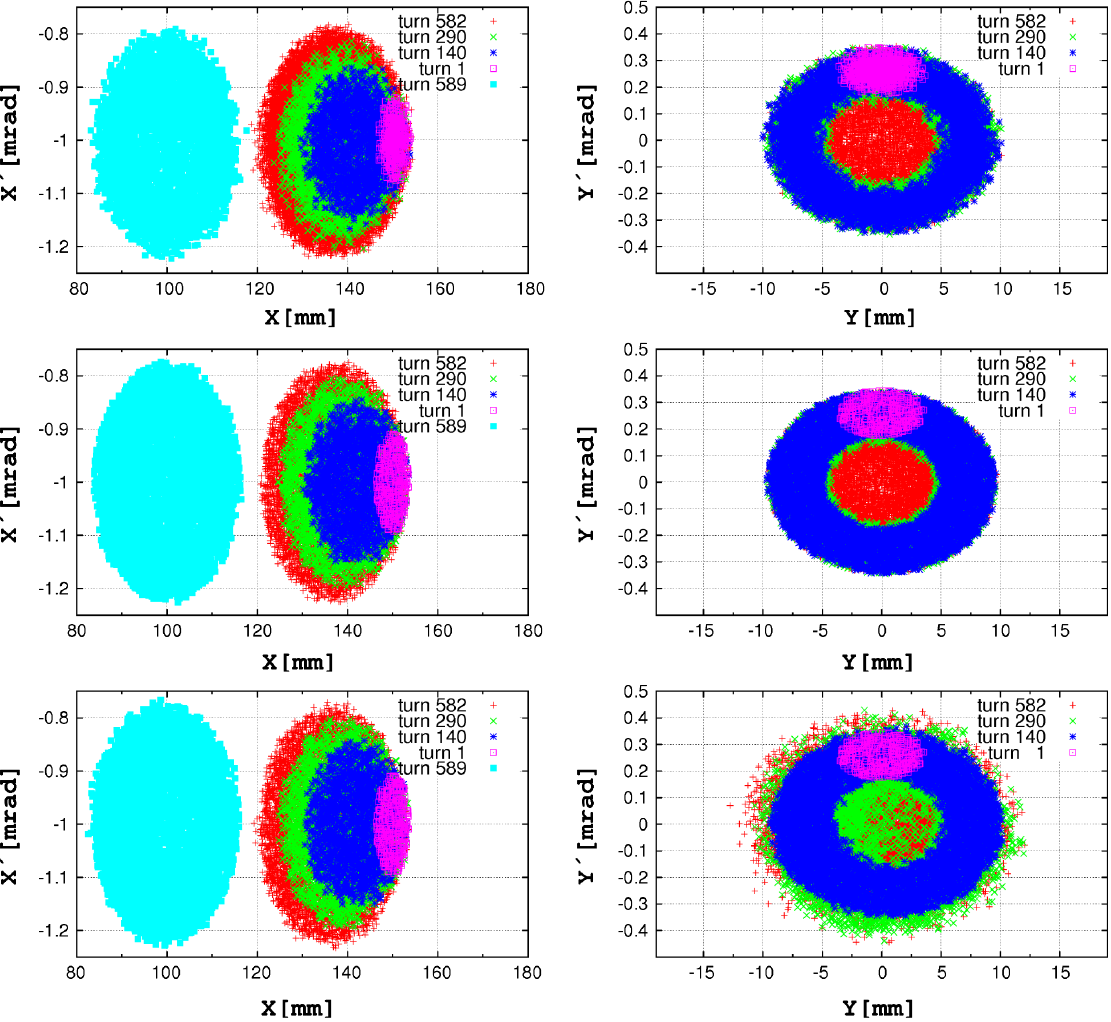
FIG. 3. Horizontal ð x; x 0 Þ and vertical ð y; y 0 Þ phase portraits of the circulating beam at the first, 140th, 290th, 582nd, and 589th turns of injection, simulated by STRUCT (top), ORBIT with zero current (middle), and ORBIT with full current (bottom).